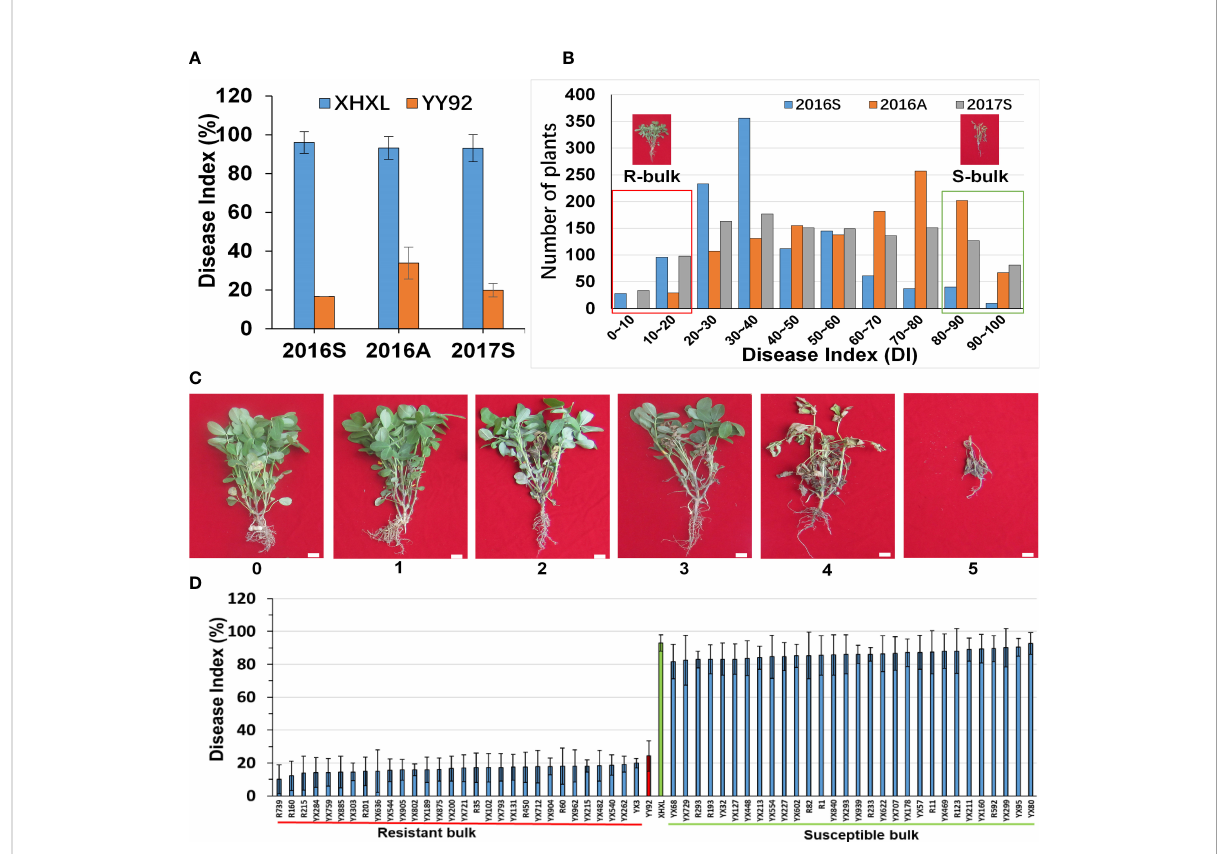
FIGURE 1 Phenotypic variations and construction of the extreme bulks for resistance to Ralstonia solanacearum infections. (A) Comparative evaluation of the stability of the resistance between the two parents in the three different crop seasons (2016_Spring, 2016_Autumn, and 2017_Spring). (B) Frequency distribution of disease indexes in the RIL population at three different times. The y-axis represented the number of plants, whereas the x-axis represented the disease index. The red dashed box represented the resistant bulk (R-bulk), and the green dashed box represented the susceptible bulk (S-bulk). (C) Classi fi cation of bacterial wilt disease severity. Disease severity was classi fi ed using the following scale: 1 = the inoculated lea fl ets either had wilt or were absent but the entire plant was intact and lacked wilt; 2 = the main stem/branches of the inoculated leaves had wilt and chlorosis; 3 = the lateral branches of the inoculated leaves had wilt or were faded green, but the main stem was green; 4 = the entire plant had wilted and died, but all its branches were green. 5 = the entire plant had wilted and dried up. Bar: 1 cm. (D) Phenotypic variations among the RILs selected for the development of extreme bulks for bacterial wilt resistance. Based on mean values from three environments each with three replications, the 30 RILs with the lowest disease index and the 30 RILs with the highest disease index were used to construct susceptible and resistant